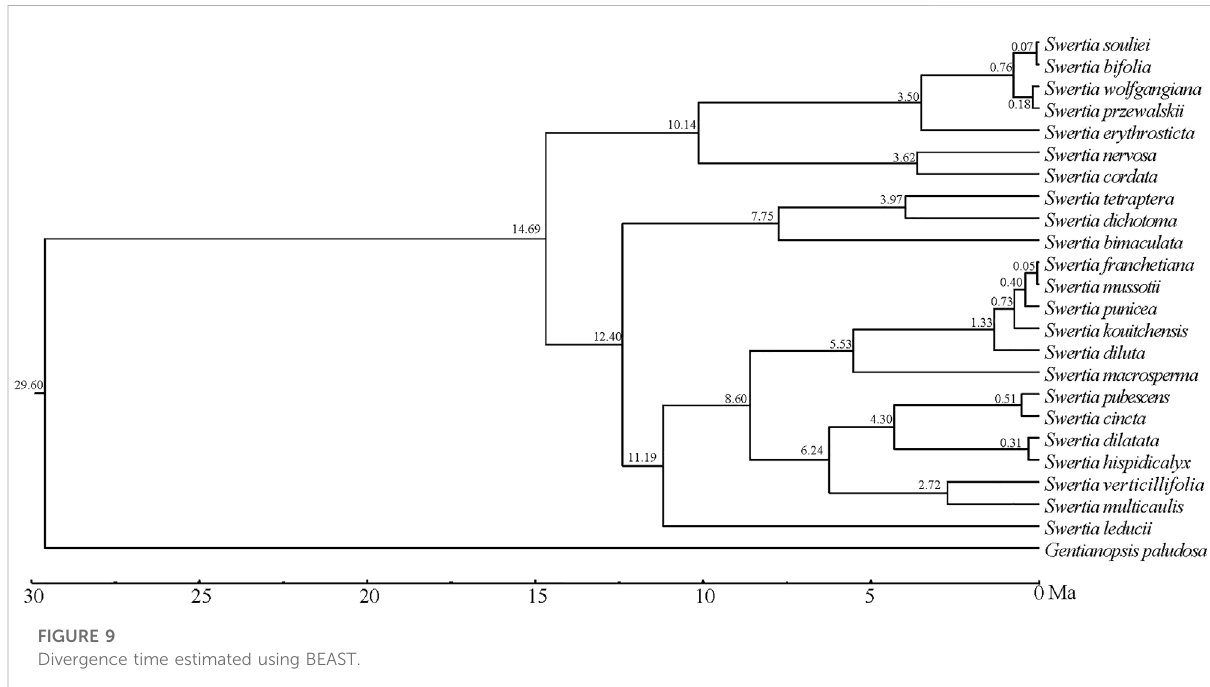
FIGURE 9 Divergence time estimated using